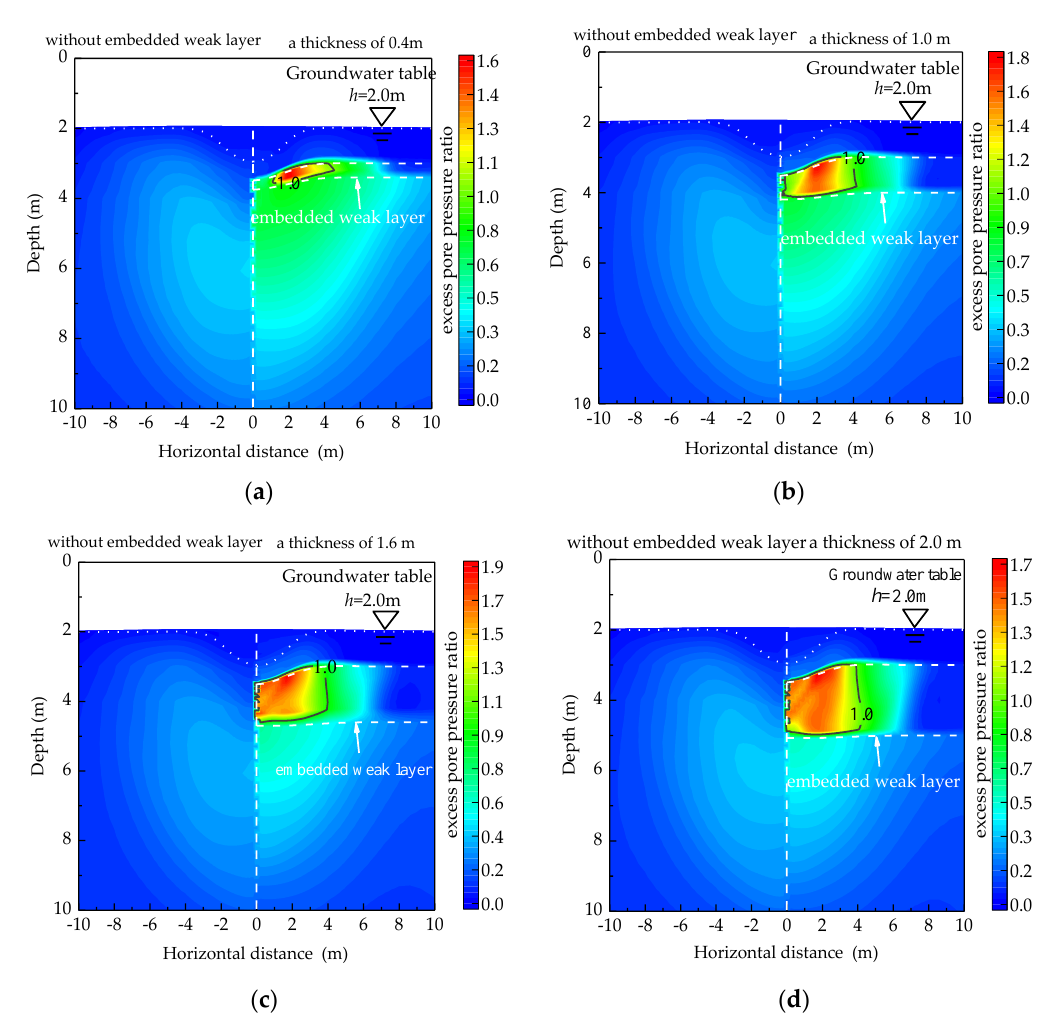
Figure 12. Distributions of excess pore water pressure ratio in grounds with embedded weak layers of different thicknesses. ( a ) 0.4 m; ( b ) 1 m; ( c ) 1.6 m; ( d ) 2.0 m.